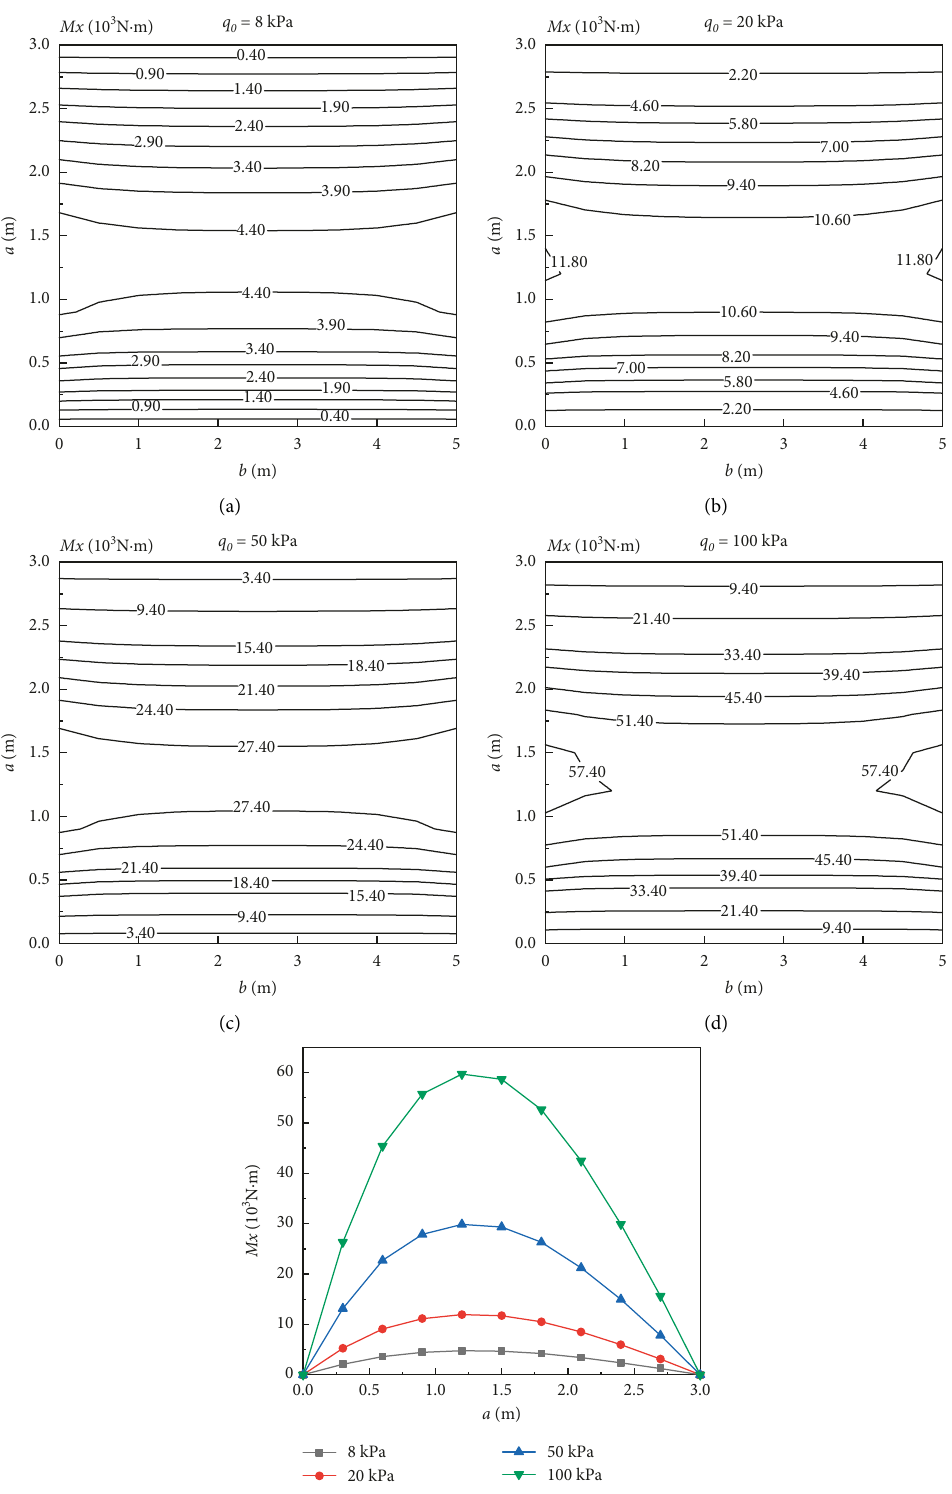
Figure 7: Effect of frost heaving force on bending moment M